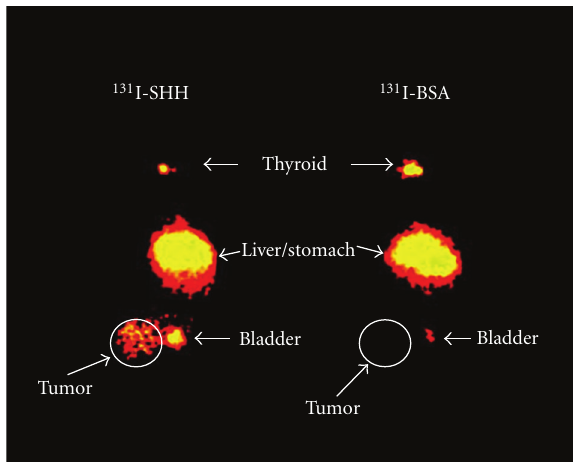
Figure 5: Planar image of Fischer 344 rats bearing breast cancer xenografts approximately 2 hours after injection of 131 I-SHH or 131 I- BSA. Tumor accumulation of the tracer is only observed in the rat injected with 131 I-SHH. The thyroid, stomach, and liver are also visible in both